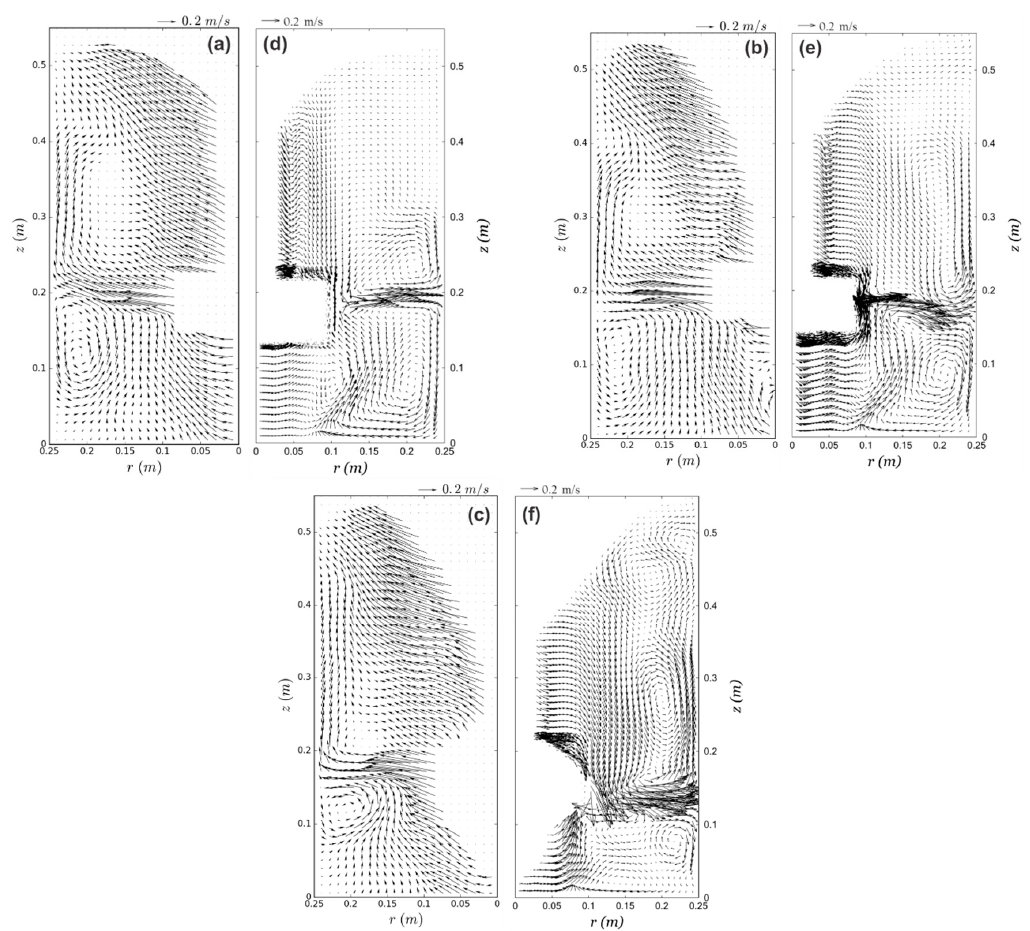
Figure 4. Measured ( left ) and computed ( right ) velocity fields at 400 rpm and 10 L/min for impeller A ( a , d ), for impeller B ( b , e ) and for impeller C ( c , f ).